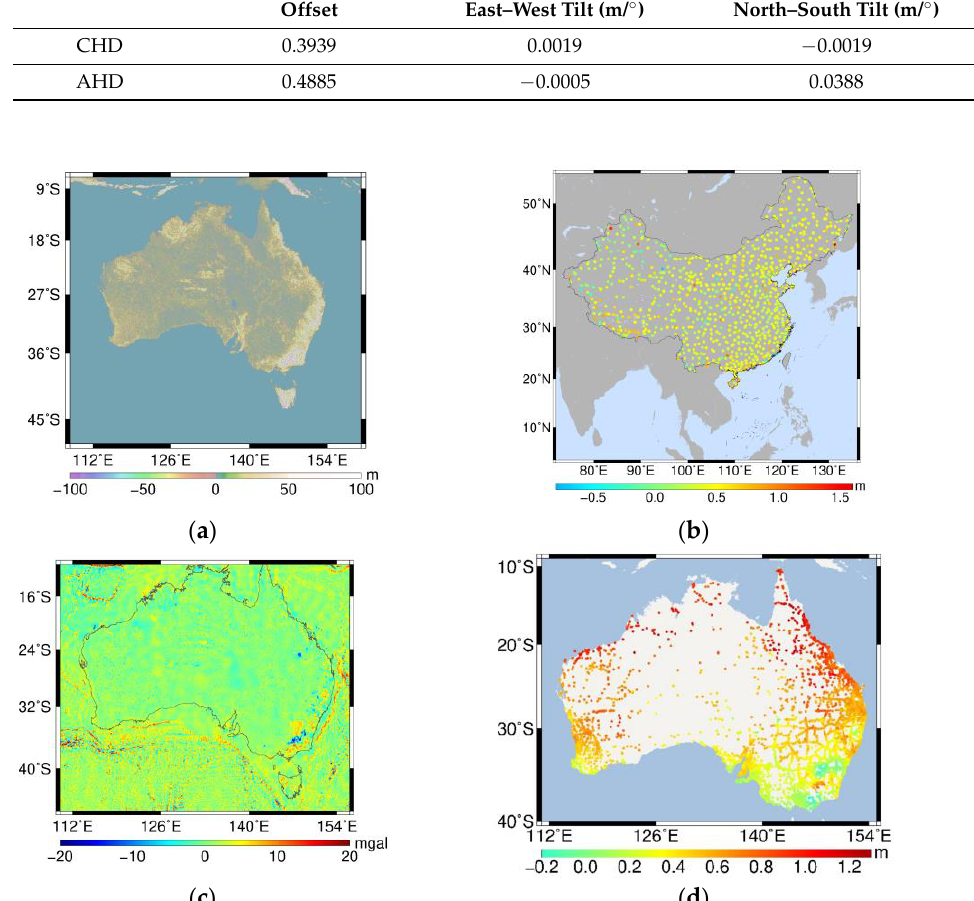
Figure 4. ( a ) The distribution of the vertical offsets of the Chinese height datum relative to the global vertical datum at the GNSS/leveling data points. ( b ) Distribution of the residual terrain model elevations in Australia. ( c ) Distribution of residual gravity anomaly in Australia. ( d ) The distribution of the vertical offsets of the Australian height datum relative to the global vertical datum at the GNSS/leveling data points.